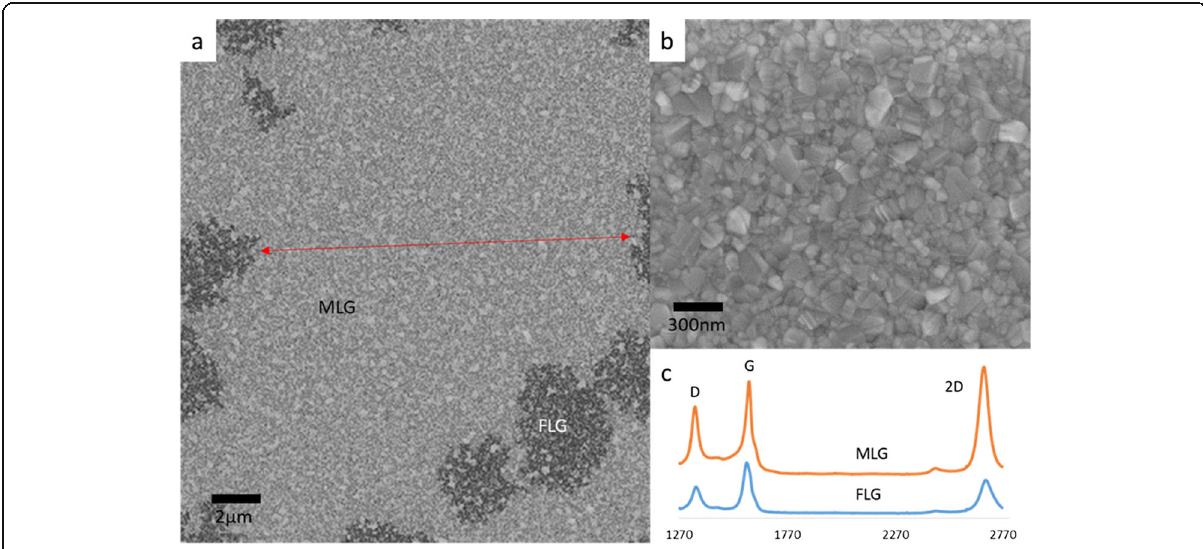
Fig. 5 Scanning electron microscope images of as-grown graphene on codeposited Ni-Au catalyst grown at 450 °C via 10 W ICPCVD which show a a 15 μ m wide section of continuous monolayer graphene (MLG) (red arrow) with few-layer graphene (FLG) islands (dark) (corresponding averaged Raman spectra in c ) and b high magnification of monolayer graphene area where the graphene is formed on the top of the catalyst